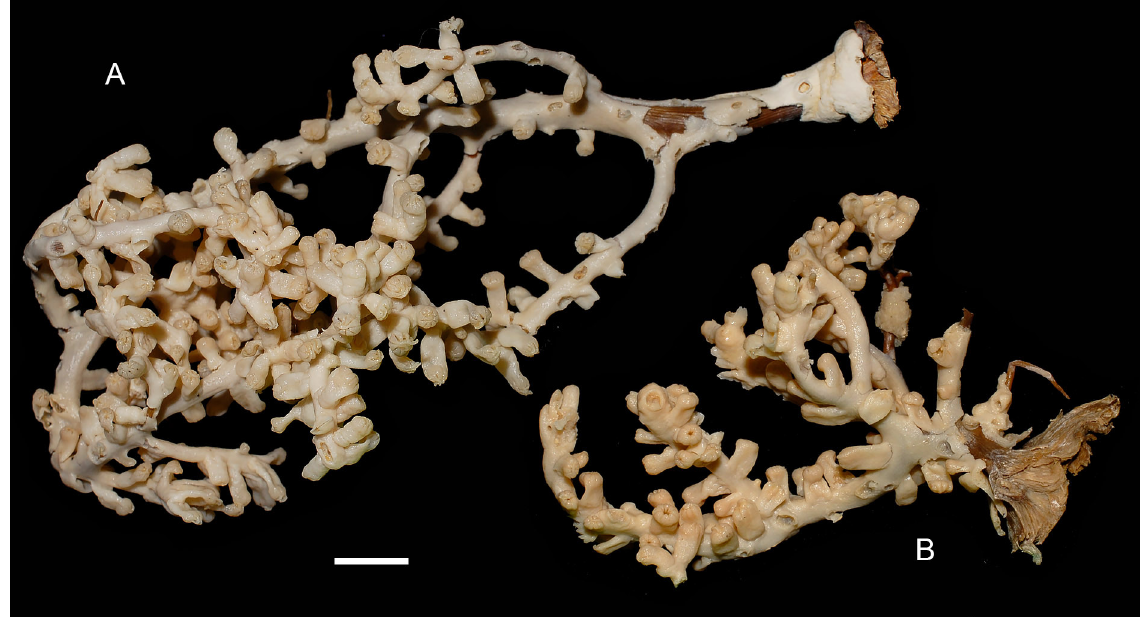
Fig. 6. Calcigorgia simushiri sp. nov. A . Holotype (MIMB 20721), Kurile Islands, Sea of Okhotsk. B . Paratype (MIMB 20703), Kurile Islands, Sea of Okhotsk. Scale bar: 10